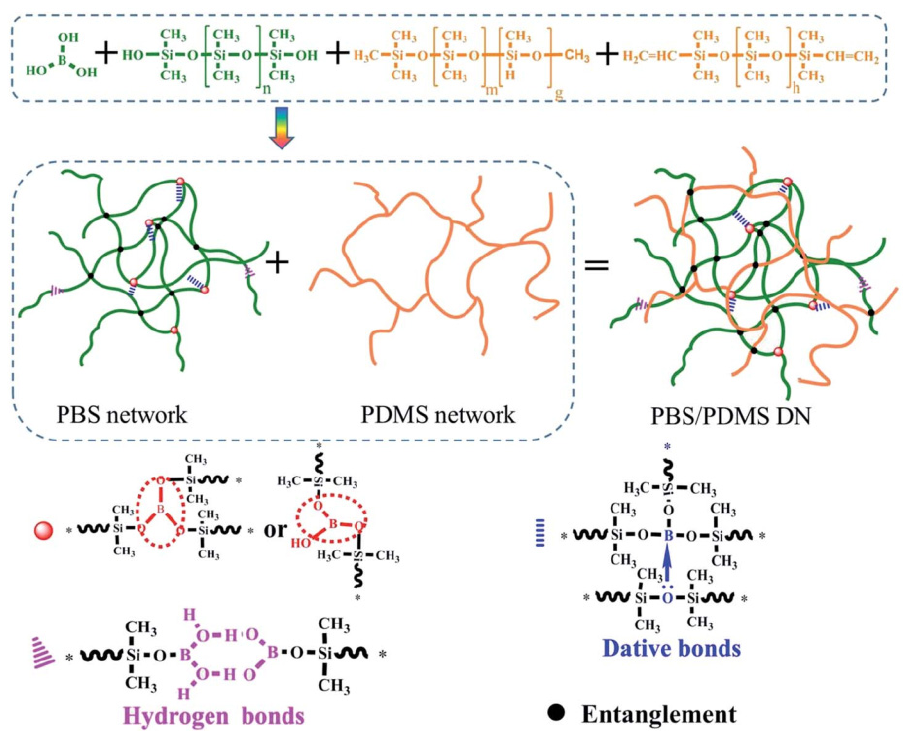
Figure 3. Formation of interpenetrating meshes of cross ‐ linked siloxanes and siloxanes with termi ‐ nal silanol groups with boric acid. Reprinted with permission from [28]. Copyright 2022 Royal So ‐ ciety of Chemistry.